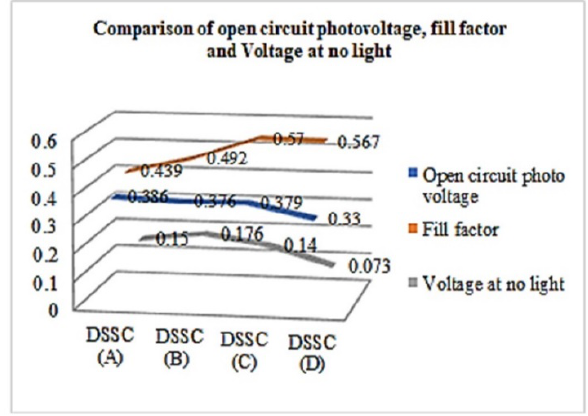
Figure 9. Performance comparison of DSSC's based on open circuit photovoltage, fill factor and voltage at no